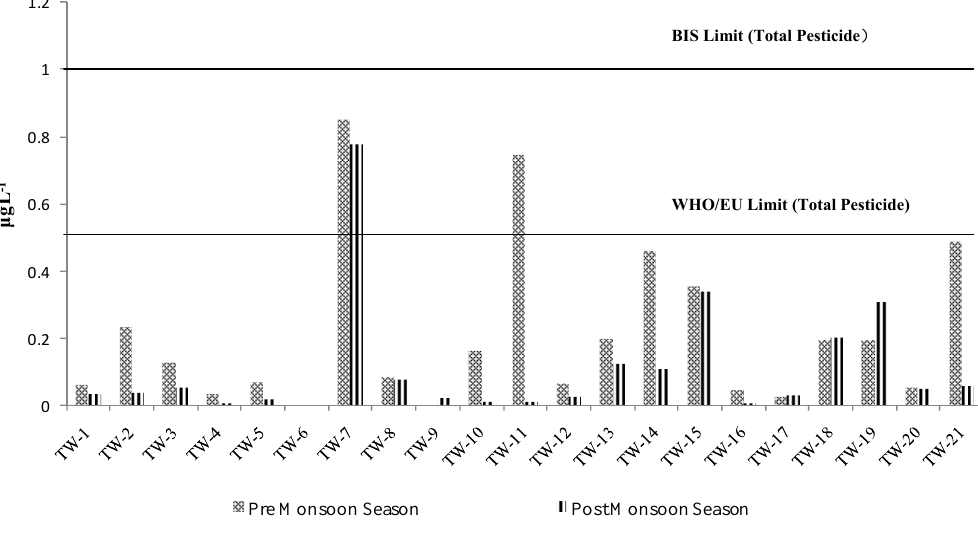
Figure 7. Comparison of borewell water quality with respect to various